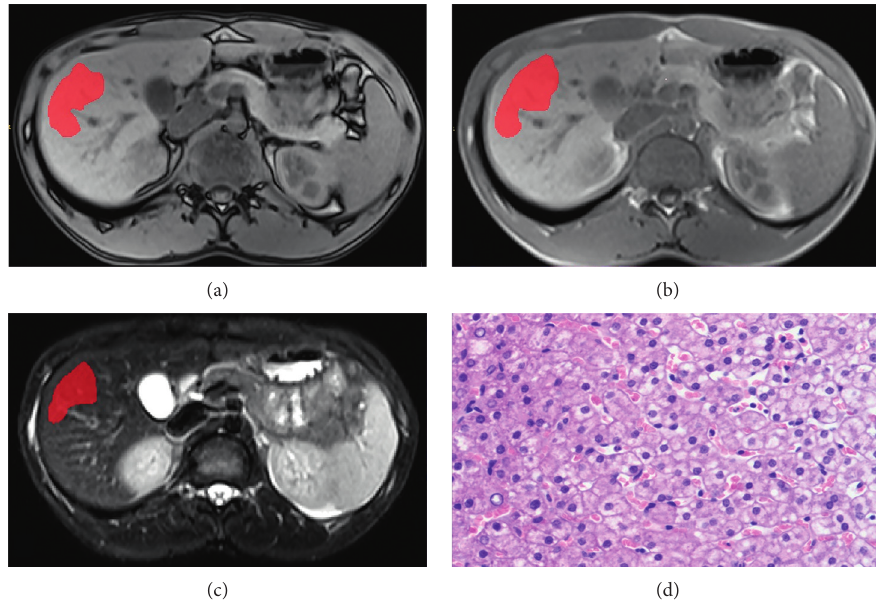
Figure 1: A 19-year-old man with hepatitis B infection. (a–c) ROI delineated using ITK-SNAP on out-of-phase T1W, in-phase T1W, and T2W images. (d) Histopathological features obtained from liver biopsy revealed stages 0-1 of fibrosis. The patient was classified in the low- stage fibrosis by the final models.